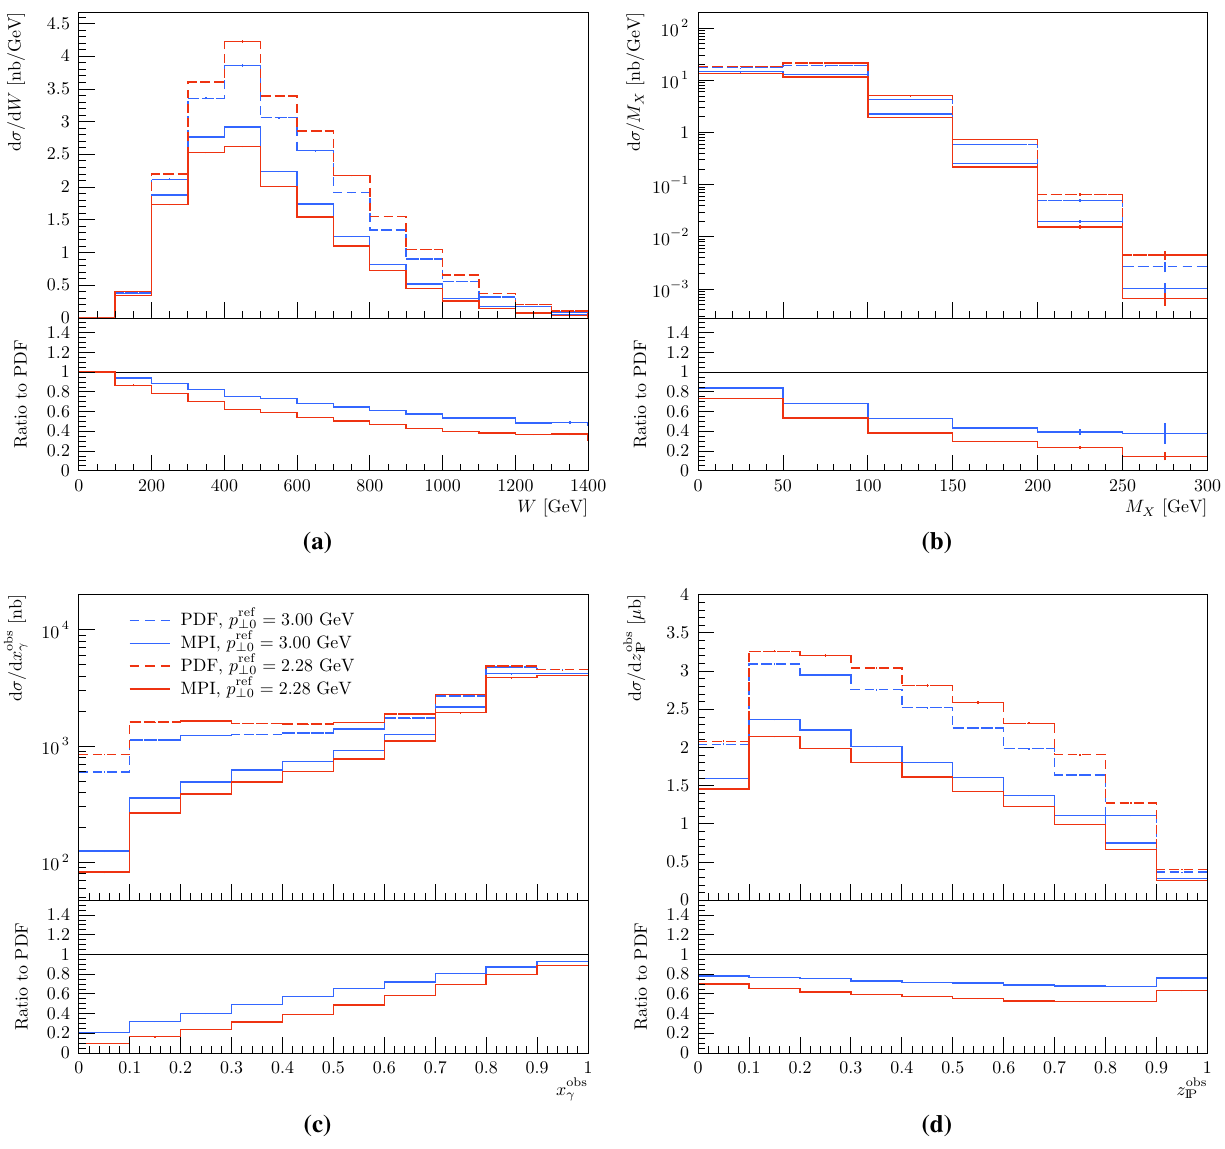
Fig. 16 Cross section for diffractive dijets in ultra-peripheral pPb collisions for observables W ( a ), M X ( b ), x obs γ ( c ) and z obs P ( d ). Vertical bars denote the statistical uncertainty in the MC